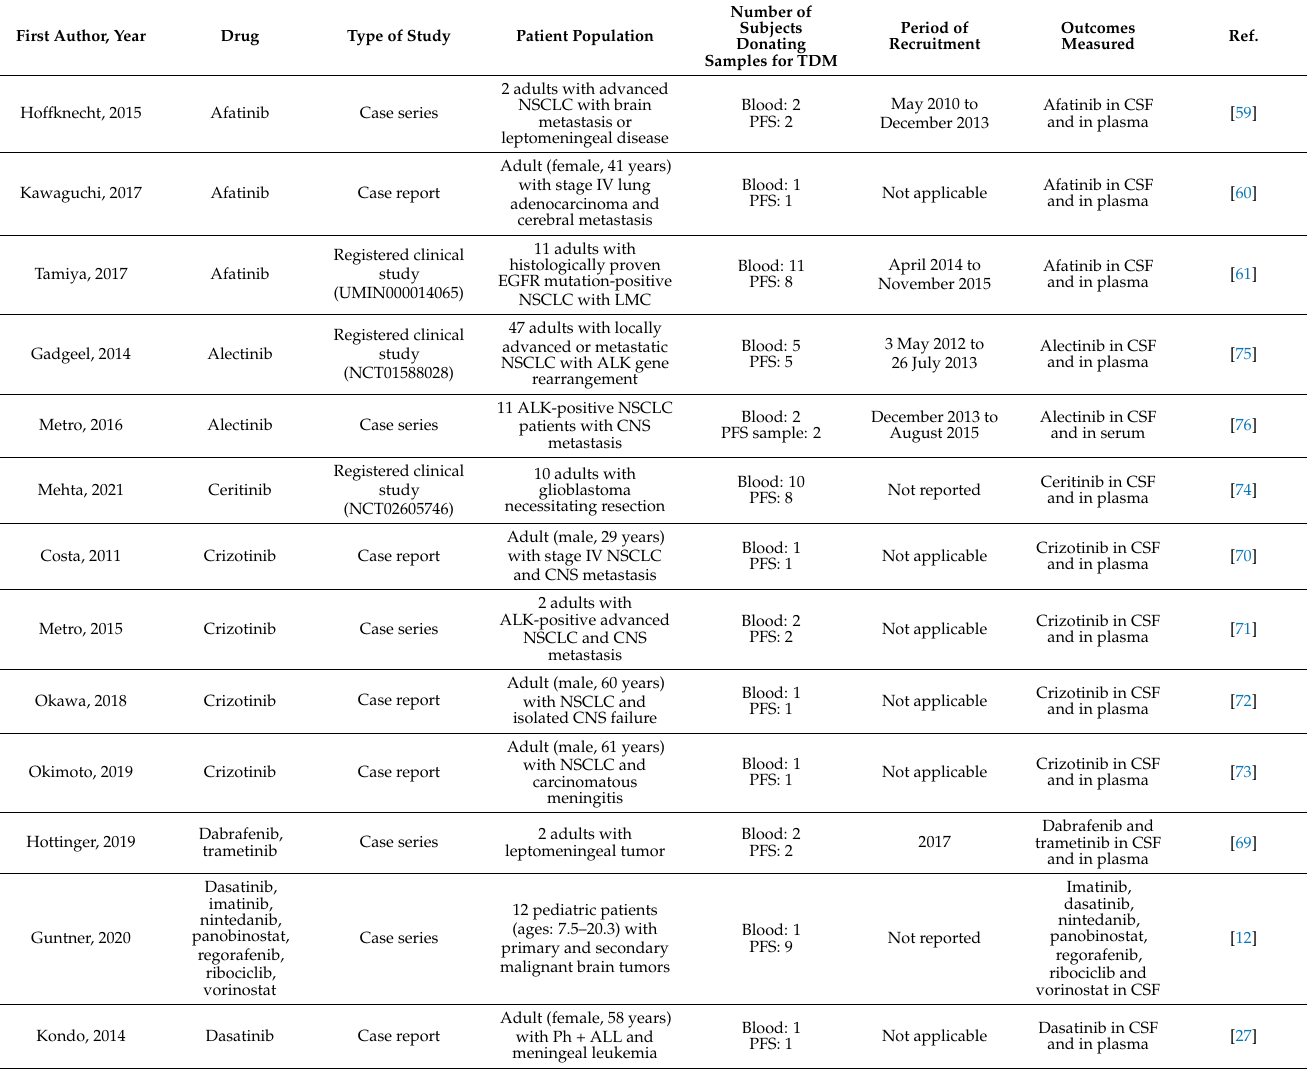
Table 2. Characteristics of the included articles. ALL, acute lymphocytic leukemia. AML, acute